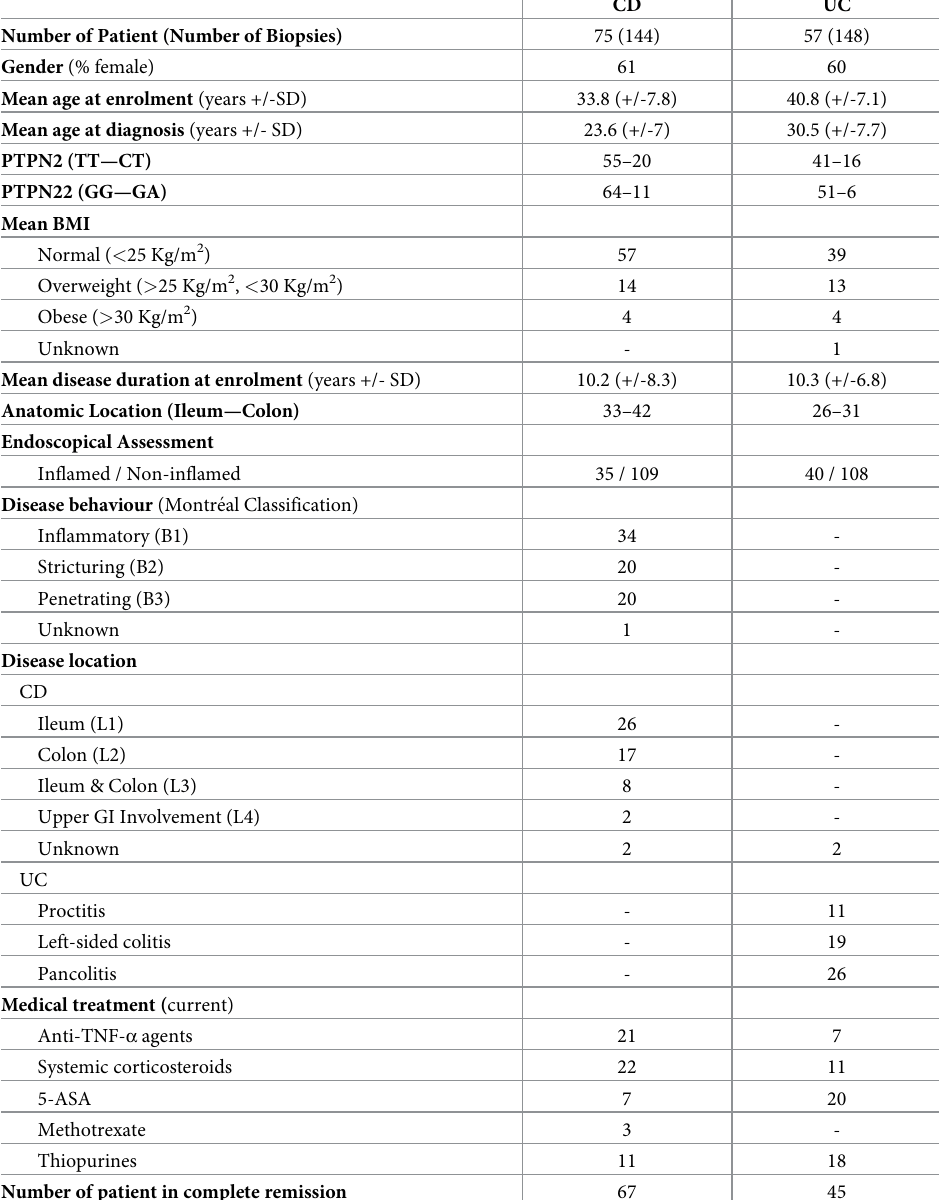
Table 1. Clinical characteristics of Swiss IBD cohort patients in